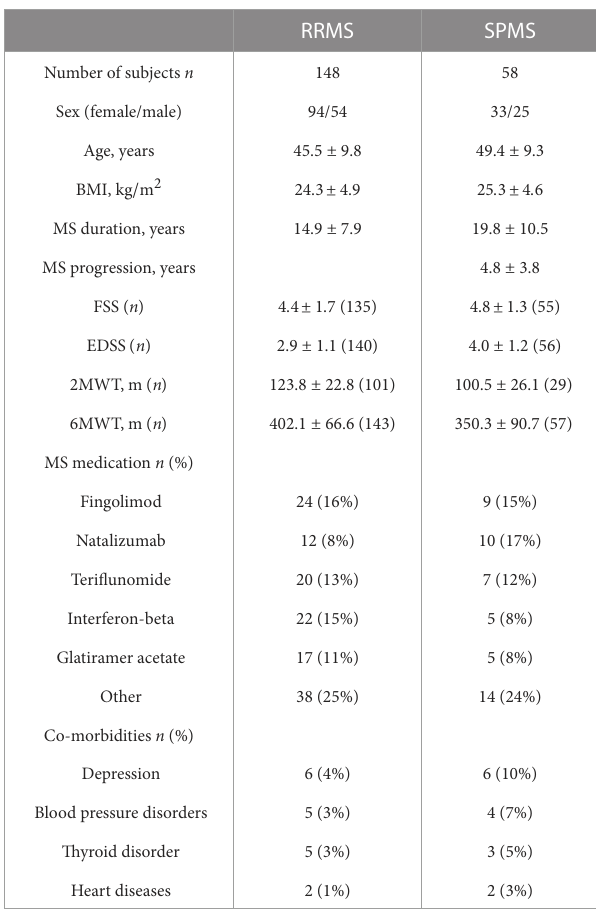
TABLE1 Mean ± standarddeviationofdemographicdataandbaseline